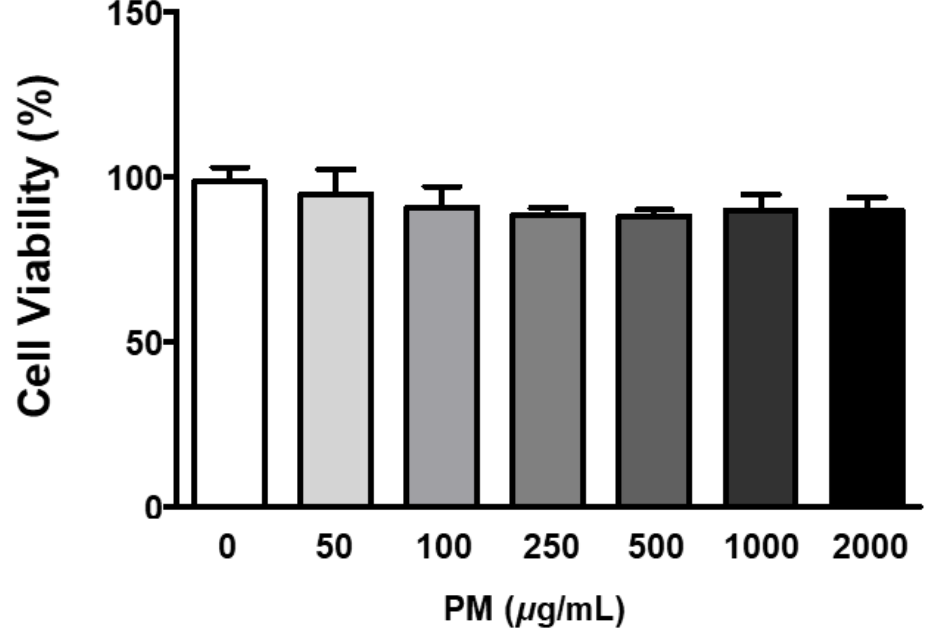
Figure 1. Effect of PM on ARPE-19 cell viability. Cells were treated with 0–2000 µ g/mL of PM for 2 h and viability was measured by the MTT assay. The relative ratios to vehicle control are presented as percentages. Data are portrayed as mean ± SD ( n = 5). Data were analyzed using one-way ANOVA followed by Tukey’s multiple comparison. No significant differences were detected. PM; particulate